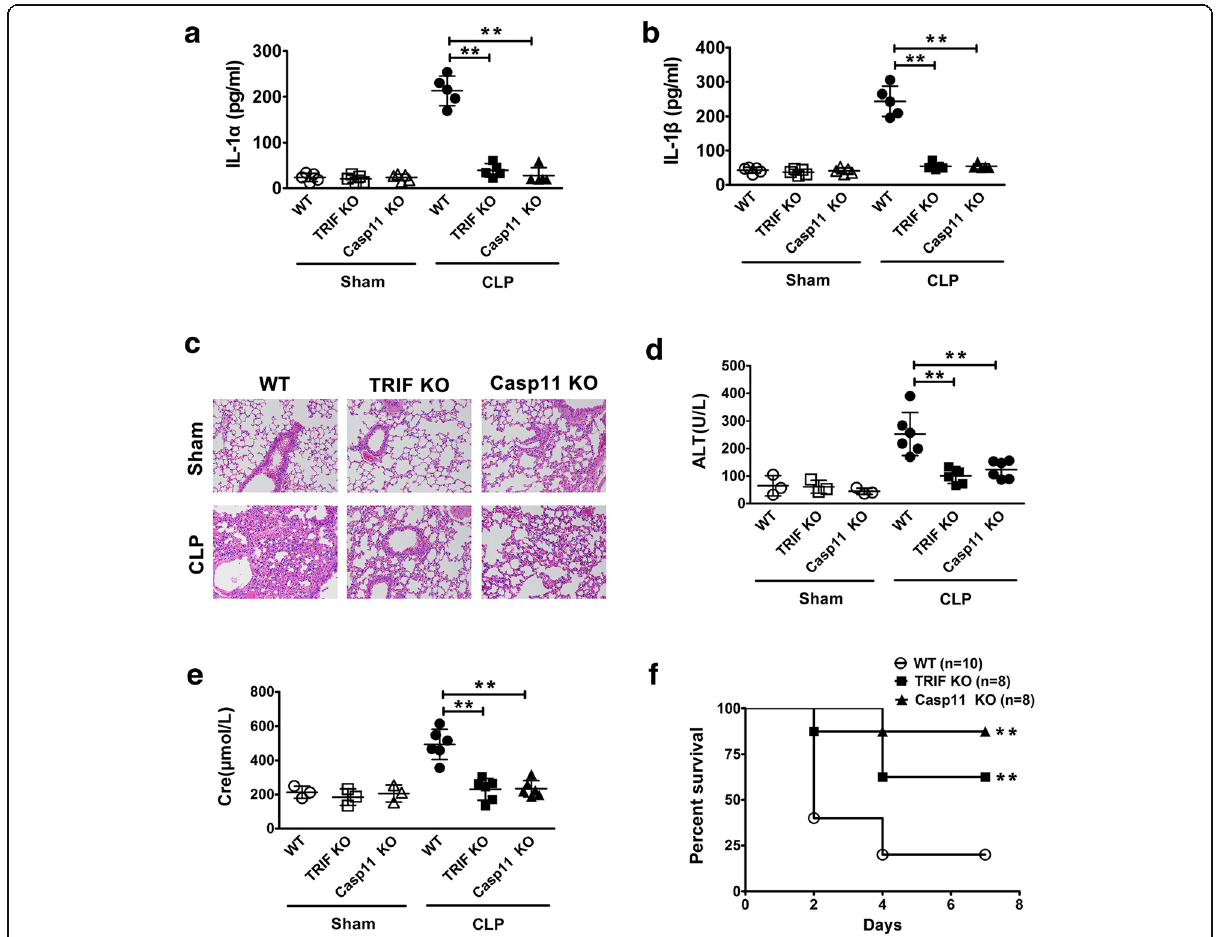
Fig. 3 TRIF is critical for caspase-11-dependent immune responses, organ injury and lethality in sepsis. a-b Serum IL-1 α and IL-1 β levels from mice of indicated genotypes were subjected to either cecum sublethal ligation and puncture (CLP) or sham operation. c H&E staining of the lungs from mice of indicated genotypes ( n =5) were subjected to either sublethal CLP or sham operation. d-e The serum alanine aminotransferase (ALT) and creatinine (Cre) levels from mice of indicated genotypes subjected to either sublethal CLP or sham operation. f Kaplan Meier survival curves for the indicated genotypes subjected to either sublethal CLP or sham operation. * P <0.05; ** P <0.01; *** P <0.001 (Student ’ s t-test and log-rank test for survival). Graphs show the mean±SD. Data are representative of at least three independent